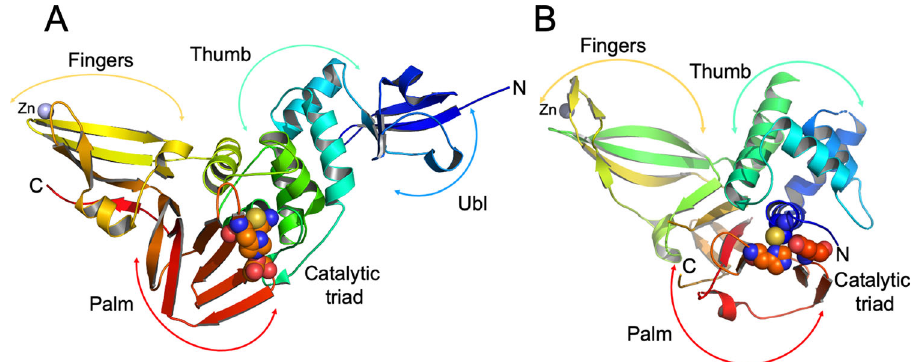
Fig. 1 Structure of PLpro from SARS-CoV-2 and comparison with human USP12. A PLpro model showing secondary structure and “ thumb-palm- fi ngers ” architecture, with domains and subdomains labeled and active site residues Cys111/His272/Asp286 represented as spheres, zinc ion is in blue. B Model of human USP12 (PDB id: 5K1B 48 ) showing similar fold and domain architecture with active site residues Cys48/His317/Asp333 represented as spheres and zinc ion in